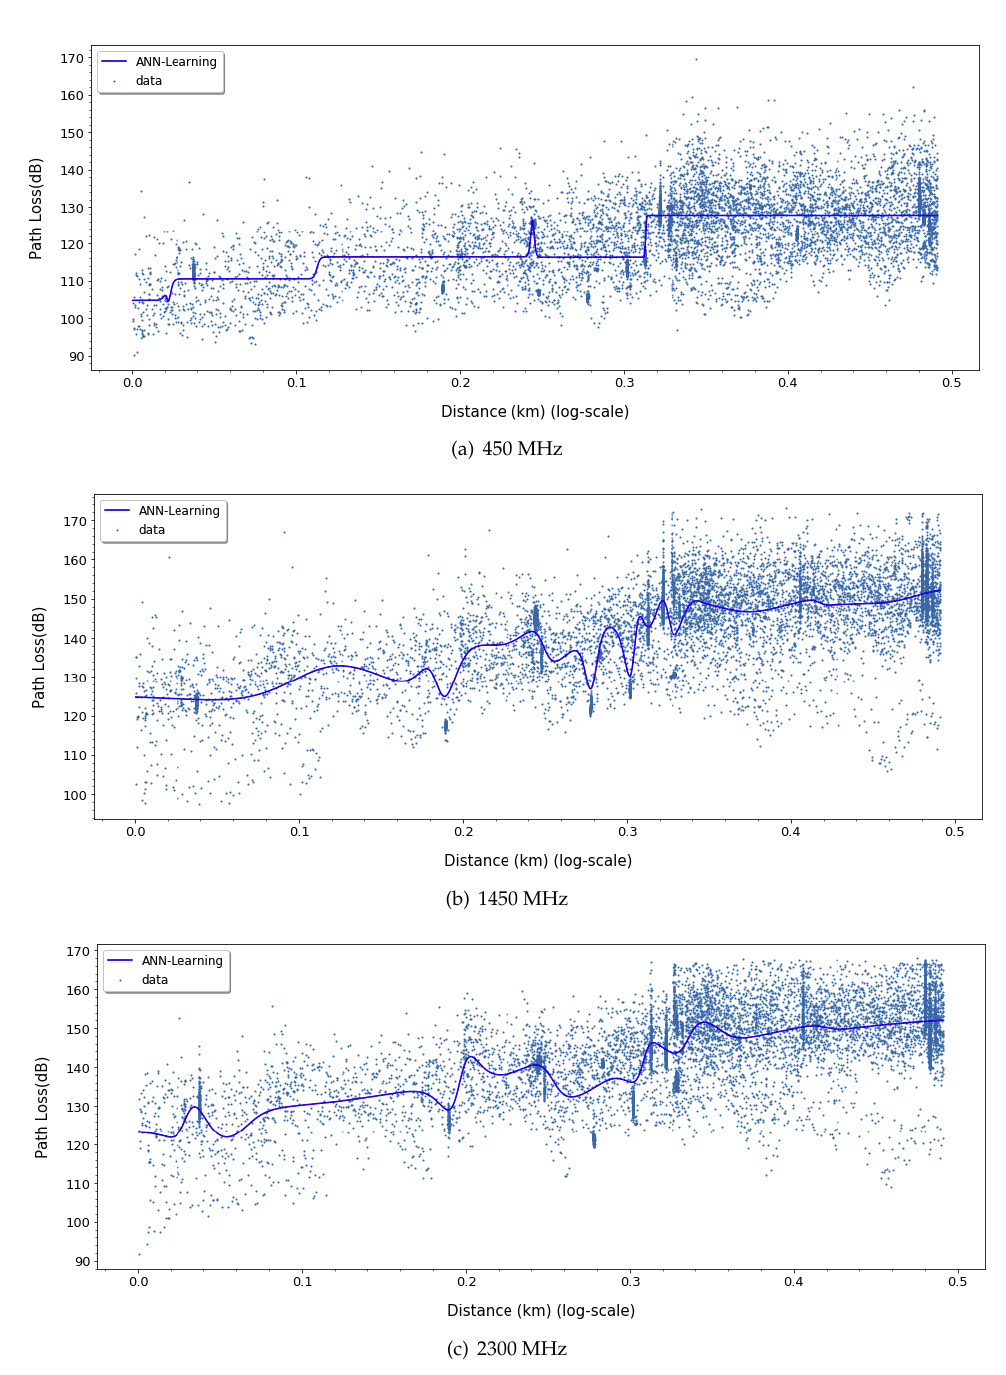
Figure 4. Single-feature-based ANN-MLP model. Table 1. Prediction loss comparison for PCA-applied and original 4-featured